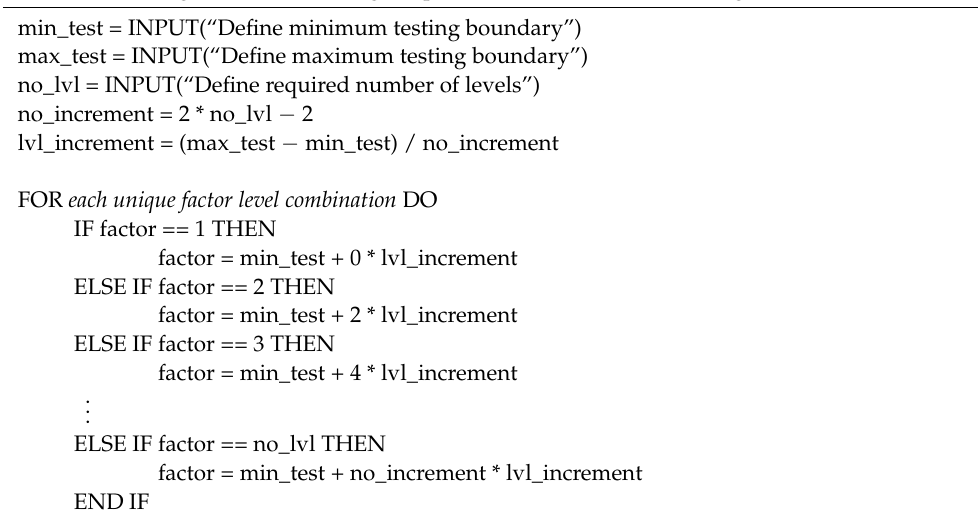
Algorithm 3. Algorithm for defining the parameter value used for testing for each factor